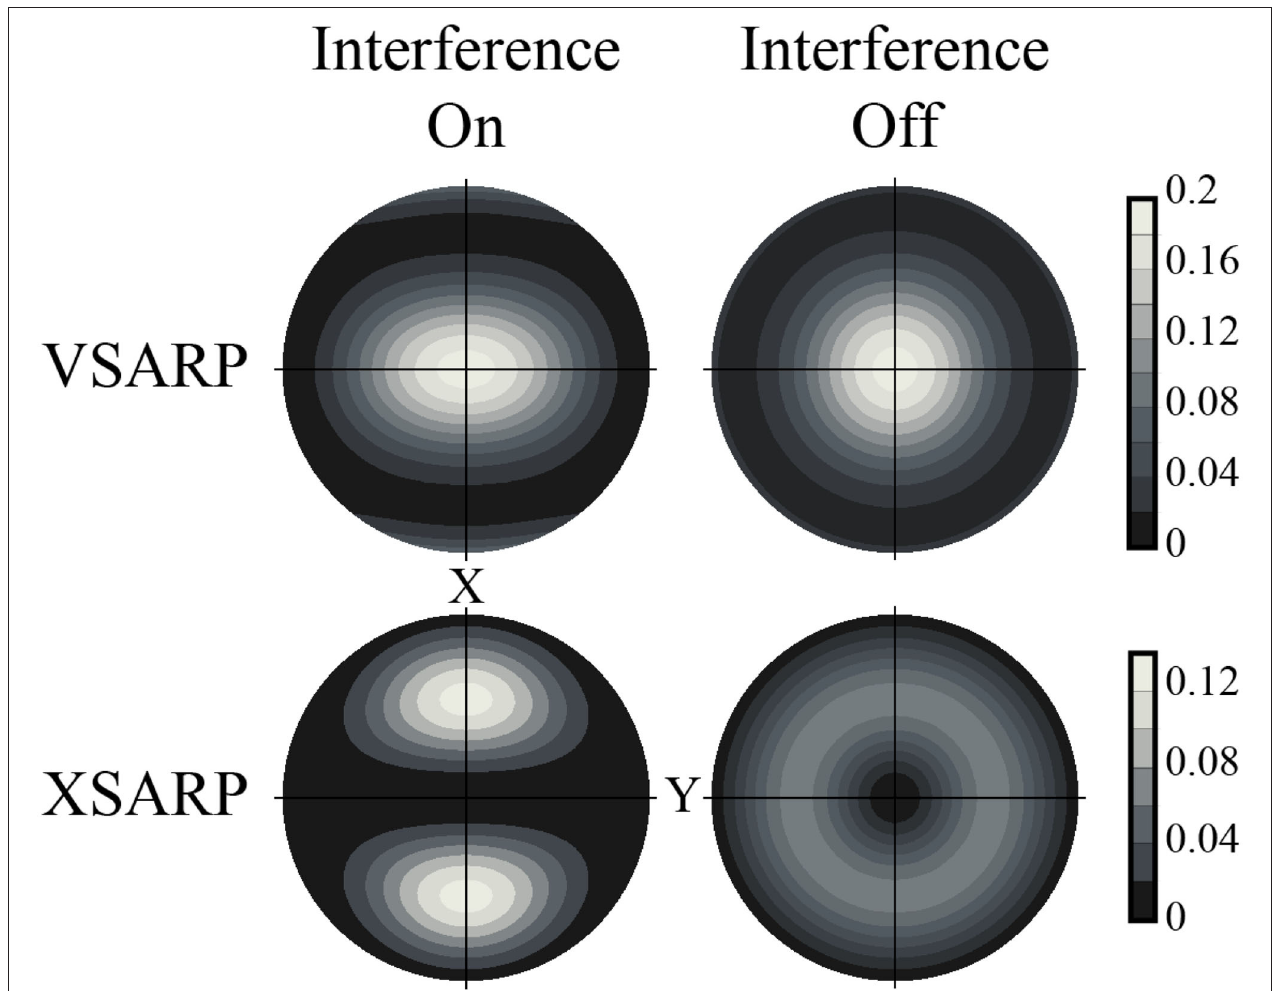
1, j f 0, m f 0) for the VSARP = = =